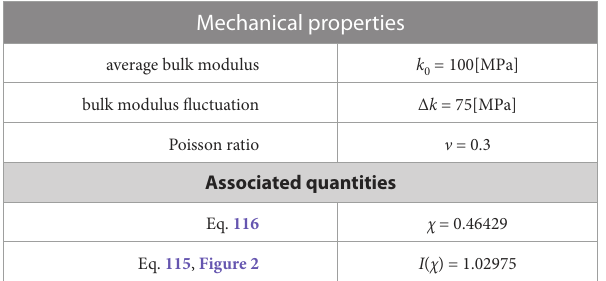
TABLE2 Mechanicalpropertiesandquantitiesassociatedtotheparticular microelasticmaterial,seeEq. 50. Mechanical